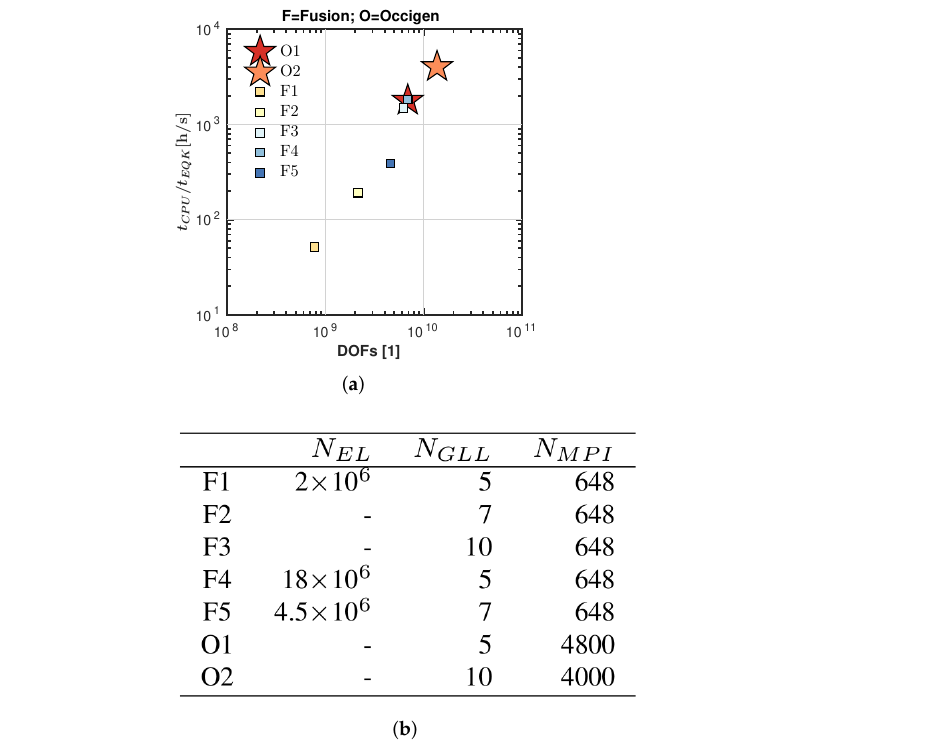
Figure 4. N E : Hexahedral element number; N GLL : number of GLL points per element); N MPI : number of CPU cores. F1-F4 and O1 refer to the simulation of the seismic response of the Kashiwazaki–Kariwa Nuclear Power Plant (Japan) during the 2007 Niigata M W 6.6 earthquake. F5 and O2 refer instead to the seismic response of the Argostoli site, object of this paper. ( a ) CPU-time per real earthquake simulation t CPU / t EQK , for different DOF numbers. ( b ) Synoptic summary of SEM3D performances.